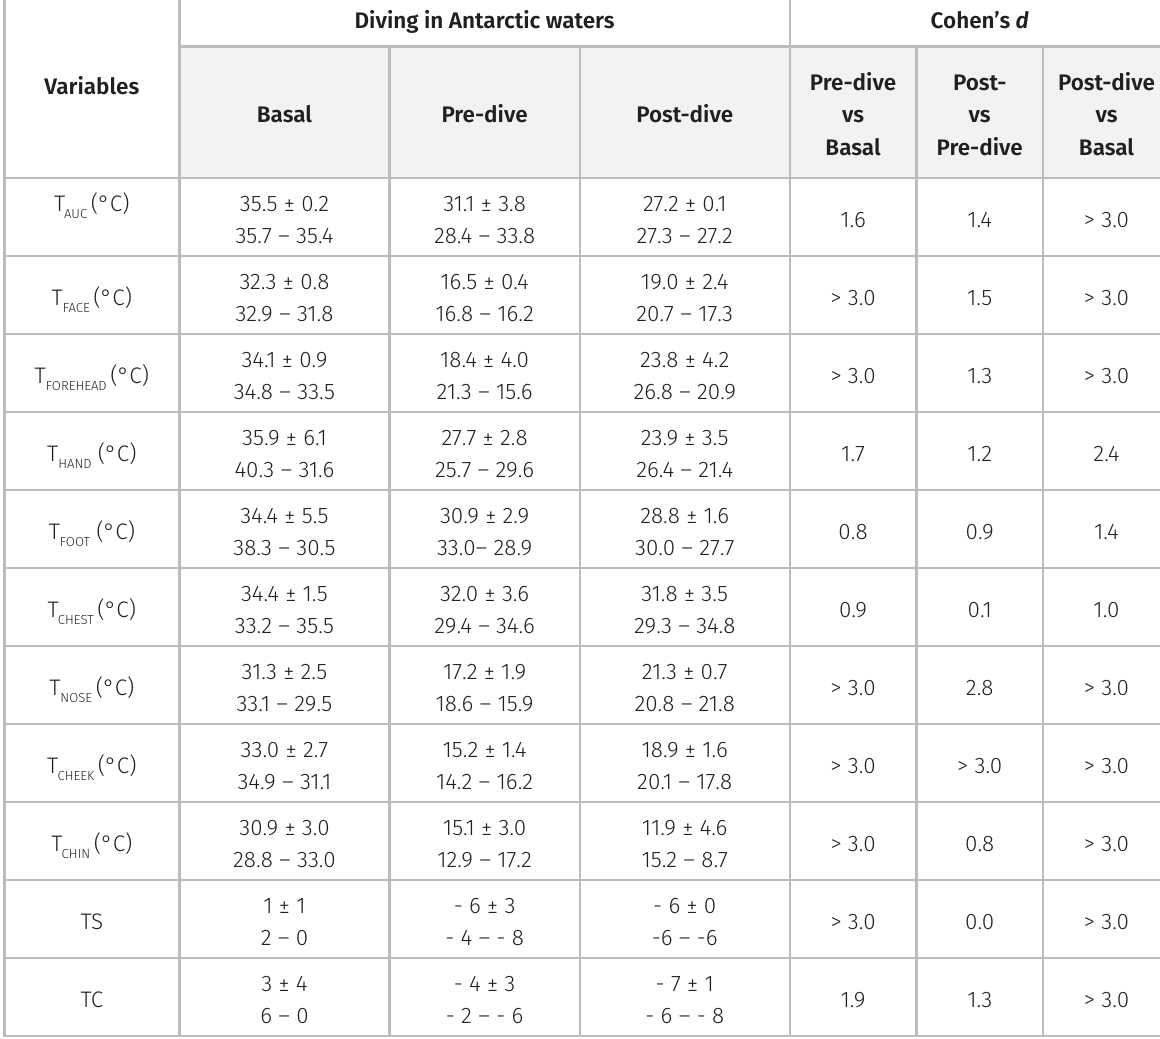
Table IV. Body temperatures and perceptual parameters measured at three time points (baseline, pre-dive, and post-dive) in the Diving group